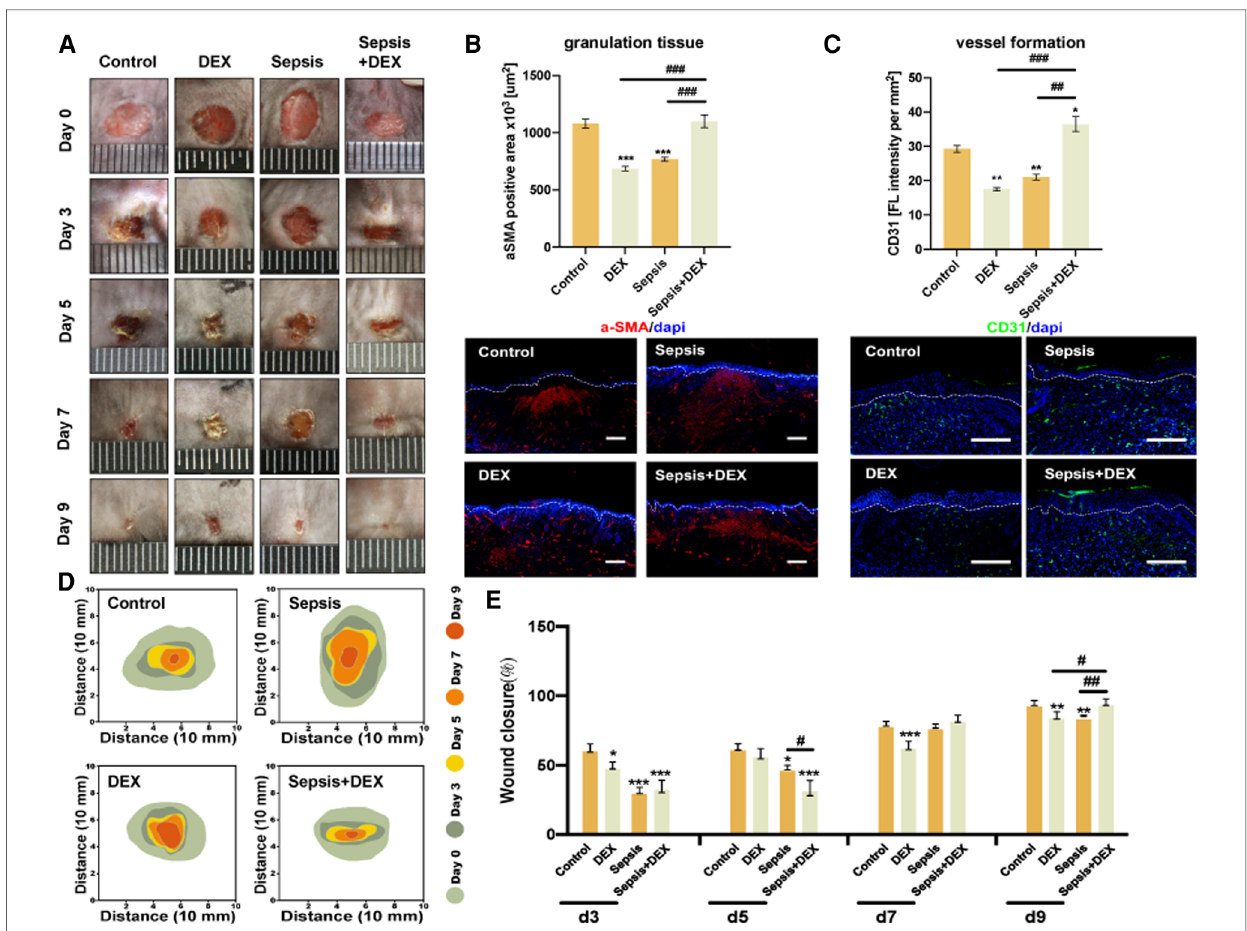
FIGURE 3 Intraperitoneal injection of dexamethasone (1 mg/kg) promoted wound healing in septic mice but delayed that in normal mice. Mice received intraperitoneal LPS (10 mg/kg) injection (sepsis and sepsis+DEX groups) or saline solution (control and DEX groups). After 24 h, dexamethasone was injected (1 mg/kg, i.p.) (DEX and sepsis+DEX groups) or normal saline (control and sepsis groups). Then, all groups had the wounding operation. Observation period included days 0, 3, 5, 7, and 9 after wounding. ( A ) Appearance of wounds on days 0, 3, 5, 7, and 9 for control, sepsis, DEX, and sepsis+DEX groups. ( B ) Granulation on day 9 after wounding. α SMA-IF (scale bar 500 μ m), granulation tissue= α SMA-positive area (mean±SEM, n =6 per group). ( C ) Vessel formation on the 9th day after wounding. CD31-IF (scale bar 500 μ m), angiogenesis=CD31 distribution/wound area (mean±SEM, n =3 per group). ( D ) Schematic diagram of wound area during 9 days for control, sepsis, DEX, and sepsis+DEX groups. Visualised by Adobe Illustrator. ( E ) Wound closure for each group. Quantitative data of image records (mean±SEM, n =6 per group). Wound closure rate was measured by the equation: ( A 0 − A n )/ A 0 × 100, where A 0 is the wound area on day 0, and A n is the wound area of days 3, 5, 7, or 9 post-wounding. * P <0.05, ** P <0.01, *** P <0.001, vs. control group; # P <0.05, ## P <0.01, ### P <0.001, vs. other groups. IF, immuno fl uorescence; α SMA, α -smooth muscle